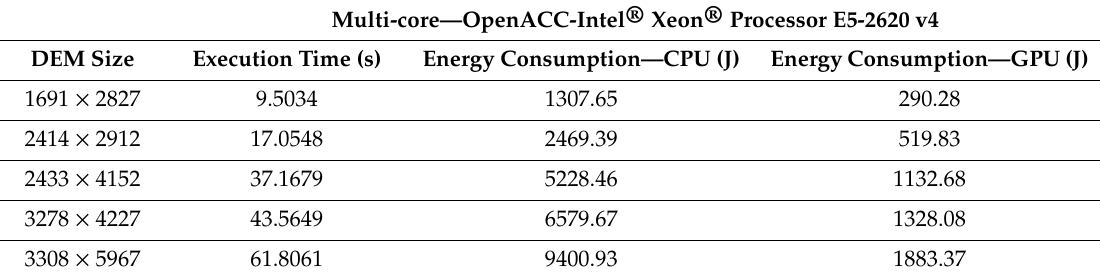
Table 6. Multi-core—OpenACC-Intel ® Xeon ® Processor E5-2620